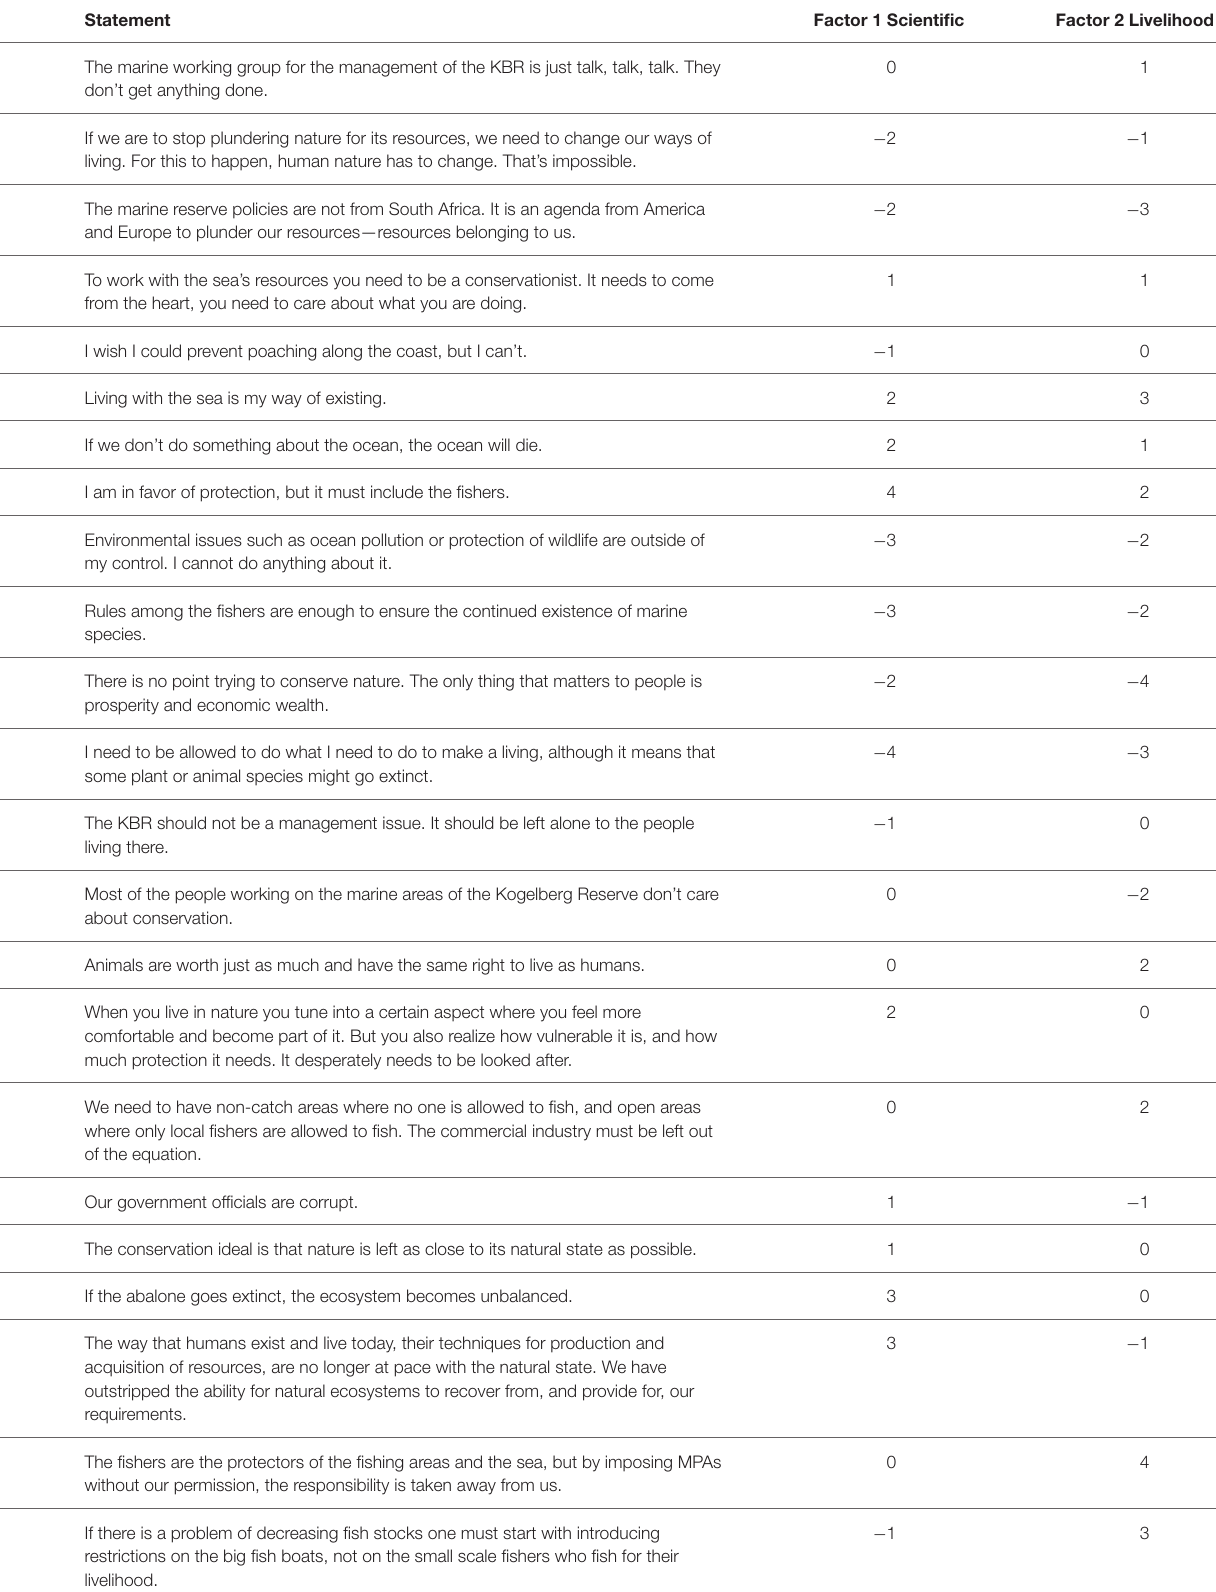
TABLE 1 | Statements, with scores on the two extracted discourses, sorted from consensus to strongest deviation. No . Statement Factor 1 Scientific Factor 2 Livelihood